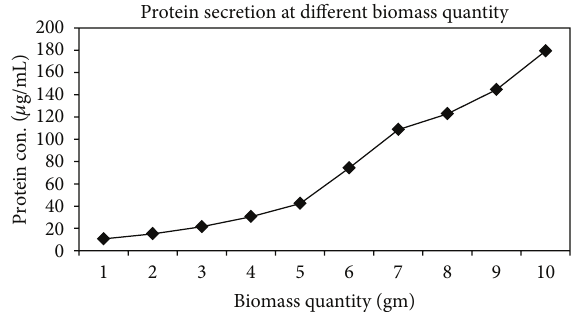
Figure 14: Effect of quantity of biomass on protein secretion. As the quantity increases, protein secretion also increases (protein estimation by Folin-Lowry’s